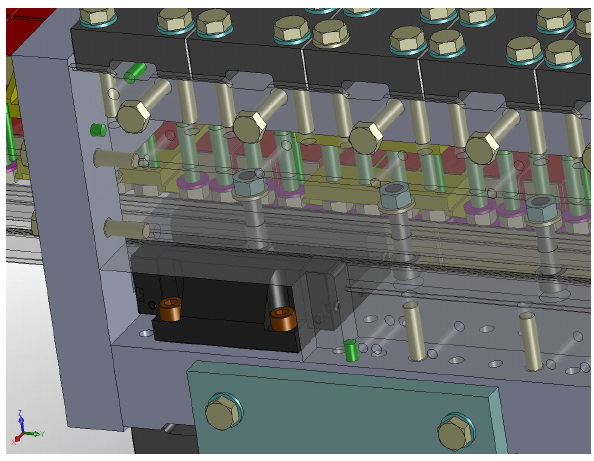
Figure 35: Recirculating ball bearings used in the electromagnetic actuator